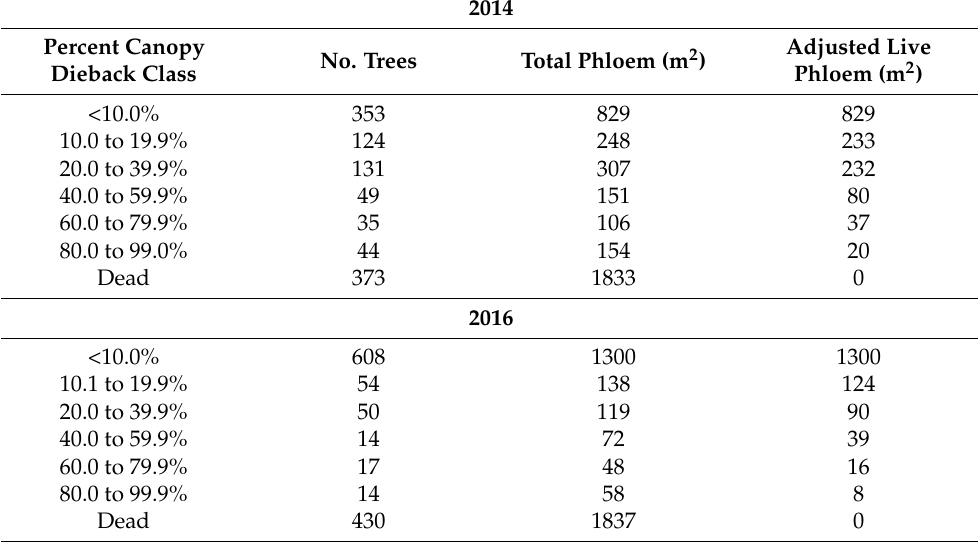
Table 2. Number of live and dead white ash ( F. americana ) trees and estimated area of phloem (m 2 ) recorded for trees in fixed radius plots (18-m radius) in 30 sites in Michigan in 2014 and 2016. Phloem area was calculated following methods of McCullough and Siegert [18] and adjusted to account for the proportion of the canopy that was